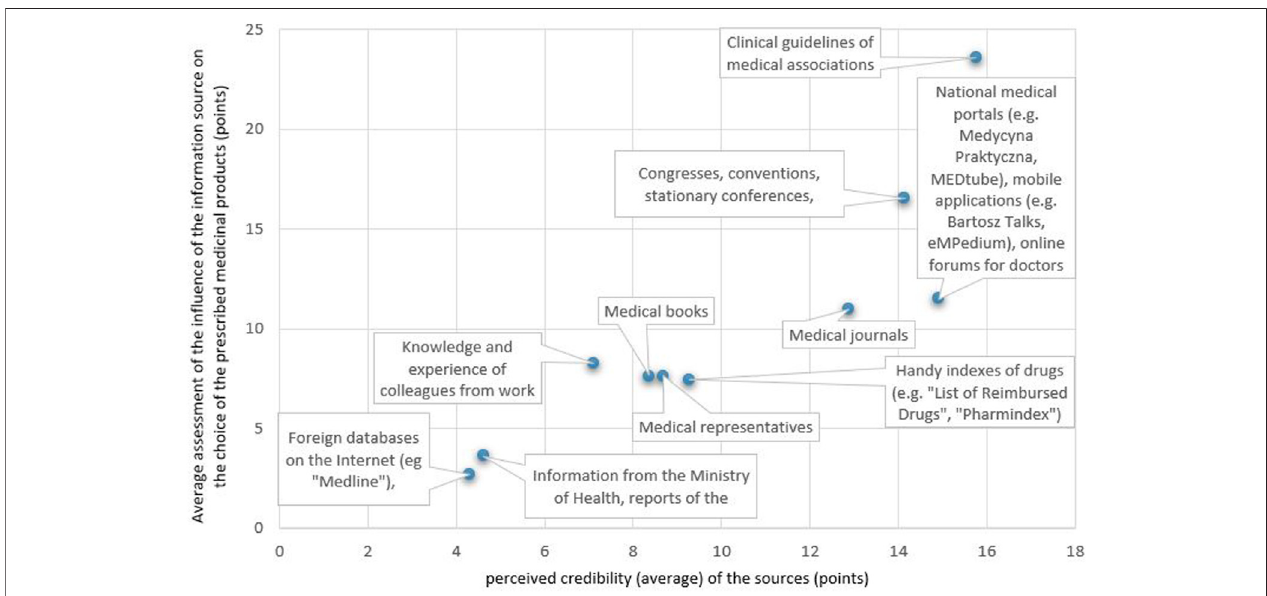
FIGURE 4 | Correlation between the perceived credibility of a source of information about a medicinal product and the in fl uence of the source on the choice of a prescribed medicinal product.